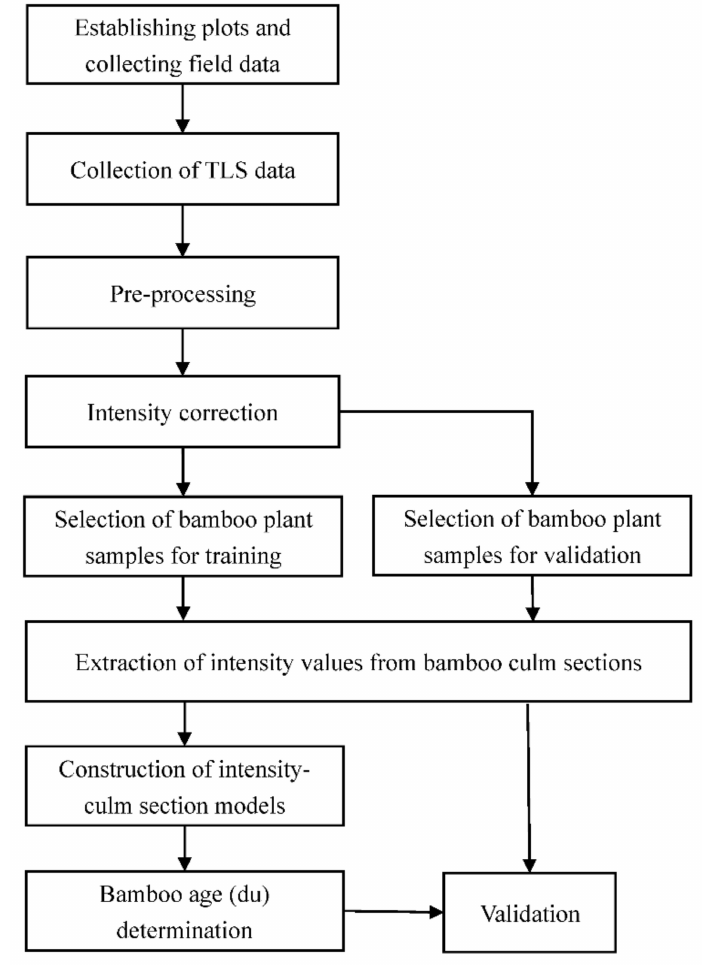
Figure 3. Flowchart of bamboo age determination.